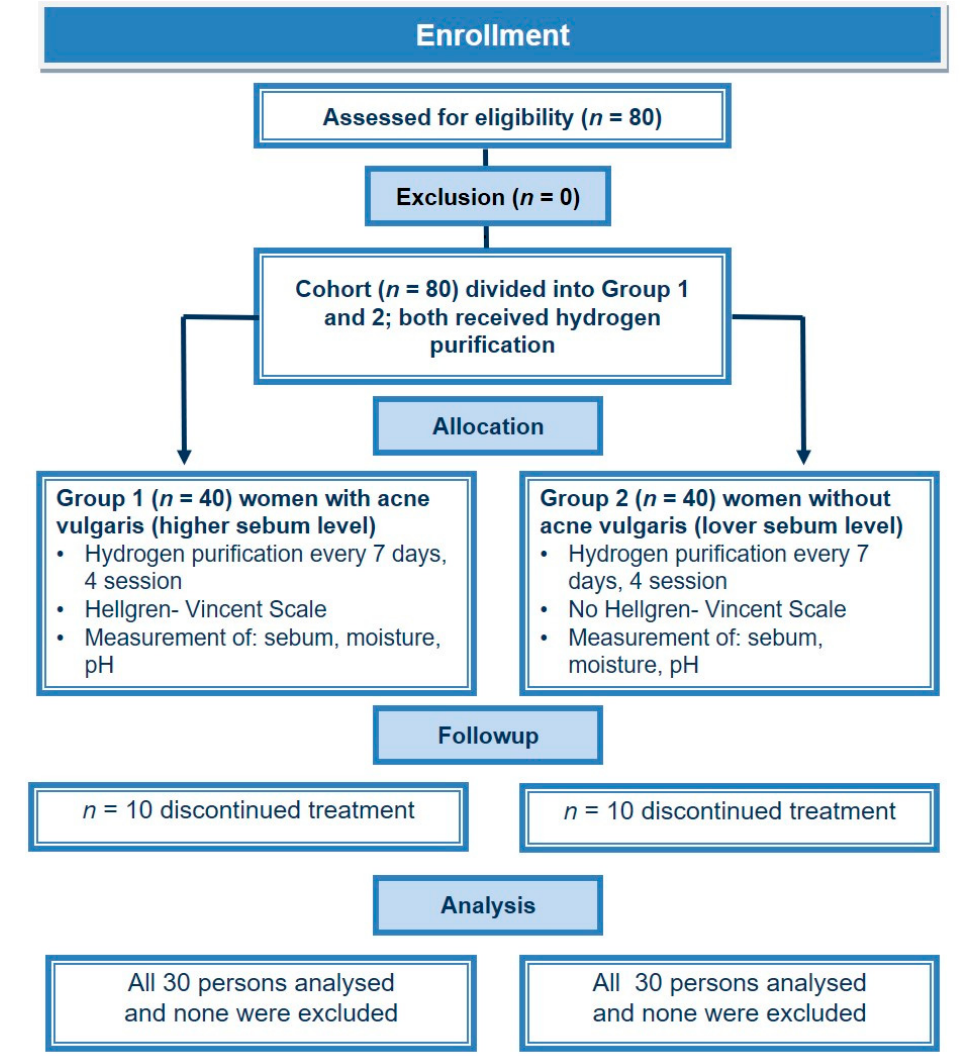
Figure 1. Consort flow chart of clinical study group 1 (acne vulgaris, AV) and group 2 (control sample, CS).